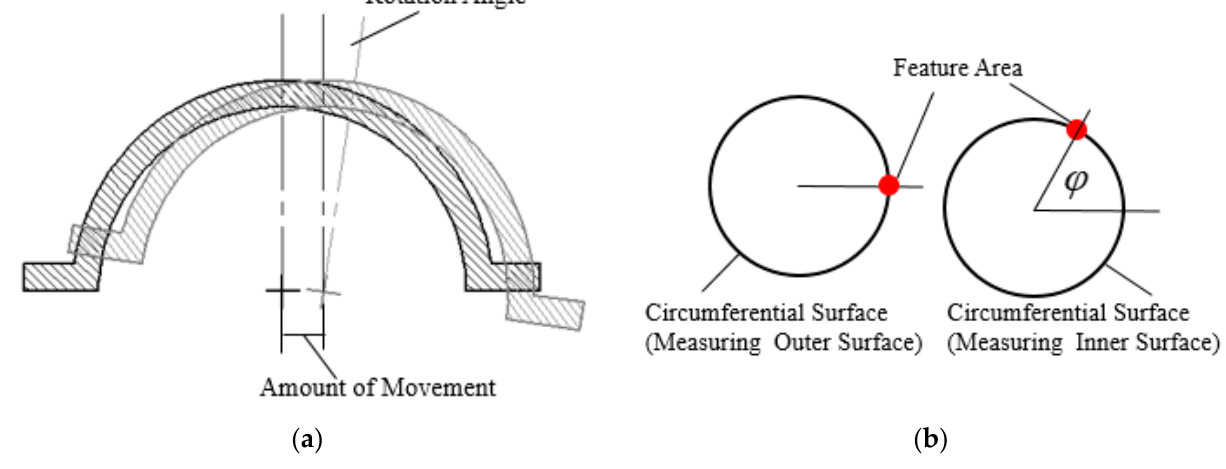
Figure 2. The schematic: ( a ) the amount of rotation and movement; ( b ) the rotation angle.